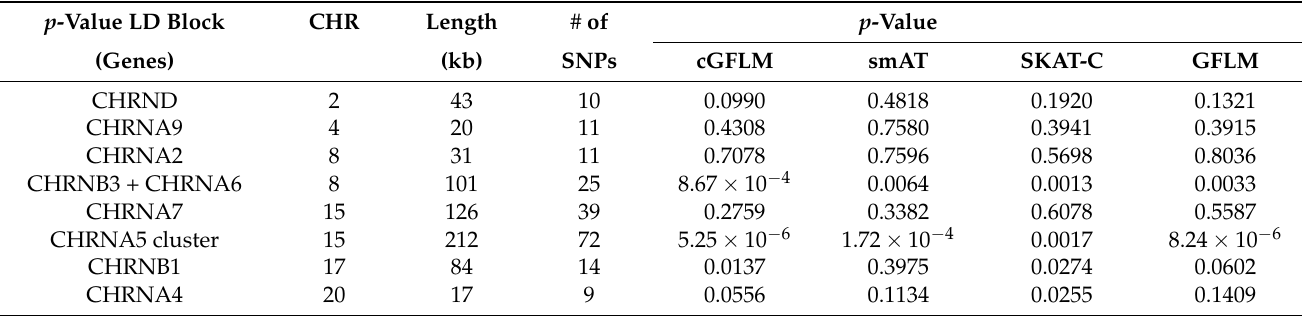
Table 3. Association tests for COGEND study based on LD blocks using single-marker association tests with Bonferroni correction (smAT), SKAT-C, GFLM and